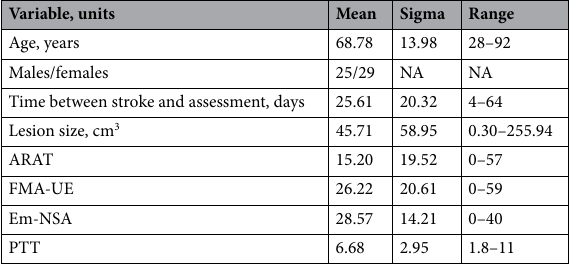
Table 1. Demographics, clinical characteristics and sensorimotor outcomes in stroke patients.